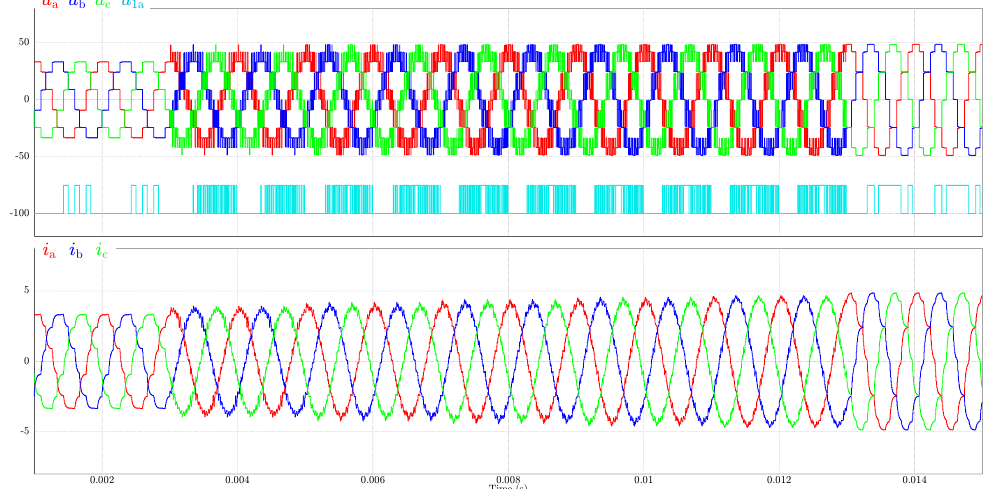
Figure 11. Example output voltage and current waveforms of the 12-pulse modular VSI during the passage between two different steady